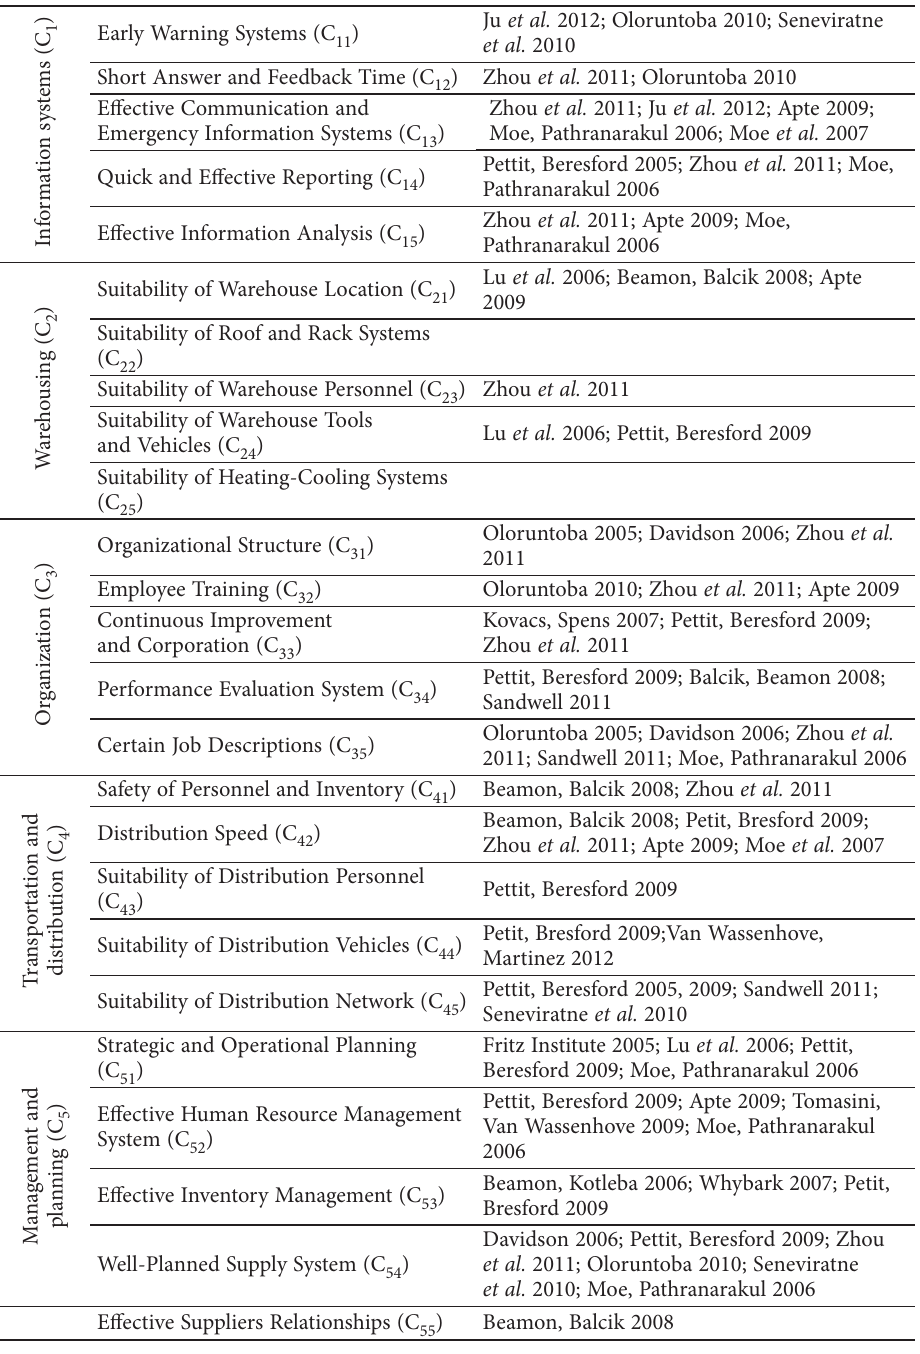
Table 1. Summary of literature review for main and sub-criteria